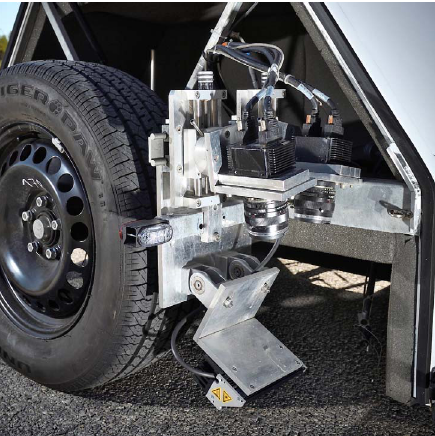
Figure 4. Photo of the texture scanner mounted in front of the CPX measurement tyre (AIT/Zinner).